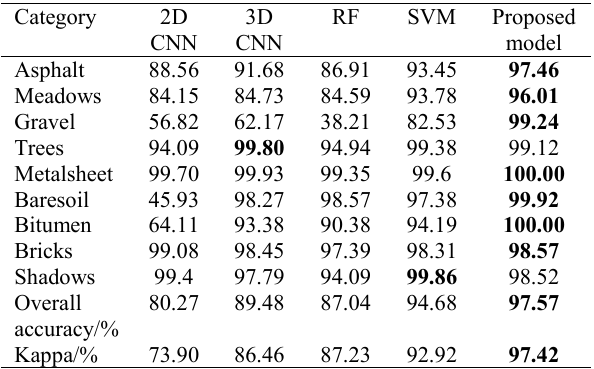
Table 2 . Comparison accuracy on Pavia dataset with another state-of-the-art method. The bold values denote the best